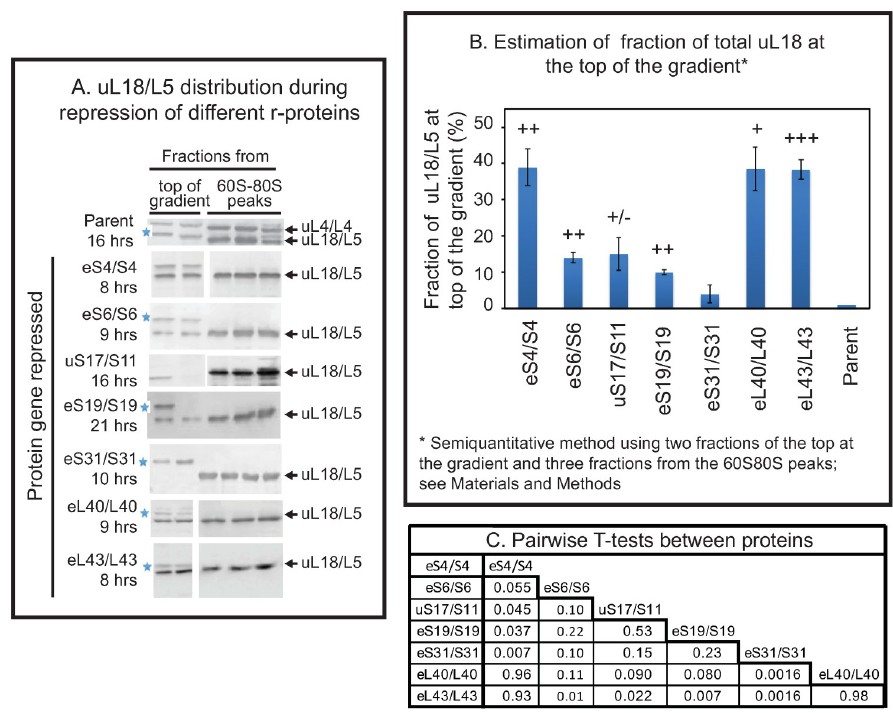
Fig 3. Quantification of extra-ribosomal uL18/L5 pool after repression of different 40S and 60S r-protein genes. P gal -eS4/S4, -eS6/S6, -uS17/S11, -eS19/S19, -eS31/S31, -eL40/L40, -eL43/L43, and the parent strain BY4741 were grown in galactose medium and shifted to glucose medium. (A) Sucrose gradients were loaded with lysates prepared after at least a four-fold increase in OD 600 after the shift to glucose medium, at which time the extra-ribosomal pool of uL18 had reached equilibrium (see Fig 4). Aliquots of consecutive fractions from the top and the 60S-80S region of the gradient were quantified from western blots probed with anti-uL18/L5. The protein whose synthesis was repressed by the shift to glucose medium is shown on the left and actual times in glucose medium for each strain are indicated below the protein name. For the abolition of the synthesis of eS4/S4, uS17/S11, e40/L40, and eL43/L43, the image was cropped from blots that include all fractions from the sucrose gradient. For repression of eS6/S6, eS19/S19, and eS31/ S31 only aliquots from the top fractions and the 60S-80S fractions were analyzed by western blot, but see also Fig 4C for a parallel experiment with Pgal-eS31/S31 in which all fractions were included in the western blot. Uncropped images are shown in Fig 2A and 2B and S1, and S2 Figs. (B) Quantification of uL18 at the top of the sucrose gradient after repressing different r-protein genes. The blots in Panel A were quantified using ImageJ. The sum of uL18 in the two top fractions was normalized to the sum of uL18 found in all five fractions. This procedure for estimating the fraction of total uL18 at the top of the gradient is validated in Materials and Methods (S2 Table). The average of three biological repeats for eS4/S4, uS17/S11, eS31/S31, eL43/L43 and two biological replicates eS6/S6, eS19/S19, eL40/L40 is shown together with the standard error of the mean. The data for each gene repression experiment was compared to the results from the parent strain by pairwise t-test. +++ indicates p < 0.001, ++ p < 0.005, + p < 0.01, +/- p < 0.1. (C) T- tests for pairwise comparison of results from different